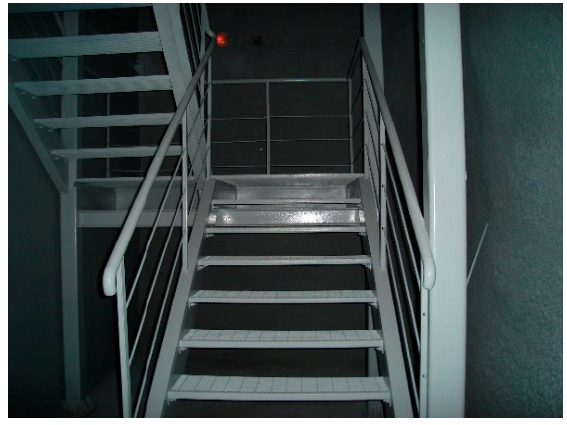
Figure 7. Underground staircase entrance.